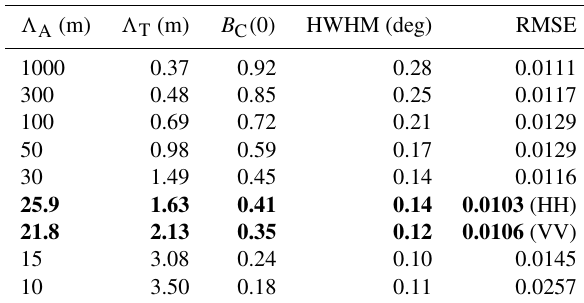
Table 1. Scattering length (cid:51) T , peak height B C ( 0 ) , and peak width (HWHM) for a set of chosen absorption lengths (cid:51) A determined from the TanDEM-X dataset (VV) of dry firn in the high-altitude accumulation area. The bold-formatted rows indicate the optimal parameter pair at VV and HH polarization. RMSE is the root mean square error between the measured and the modeled value of I r , 0